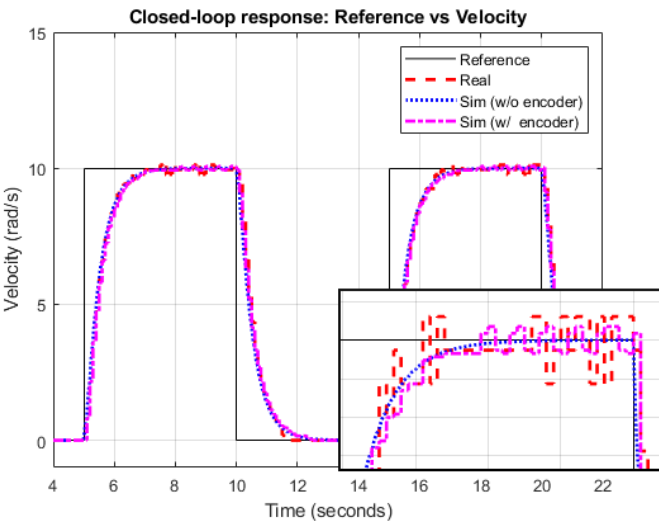
Figure 4. PI controller with motor model.